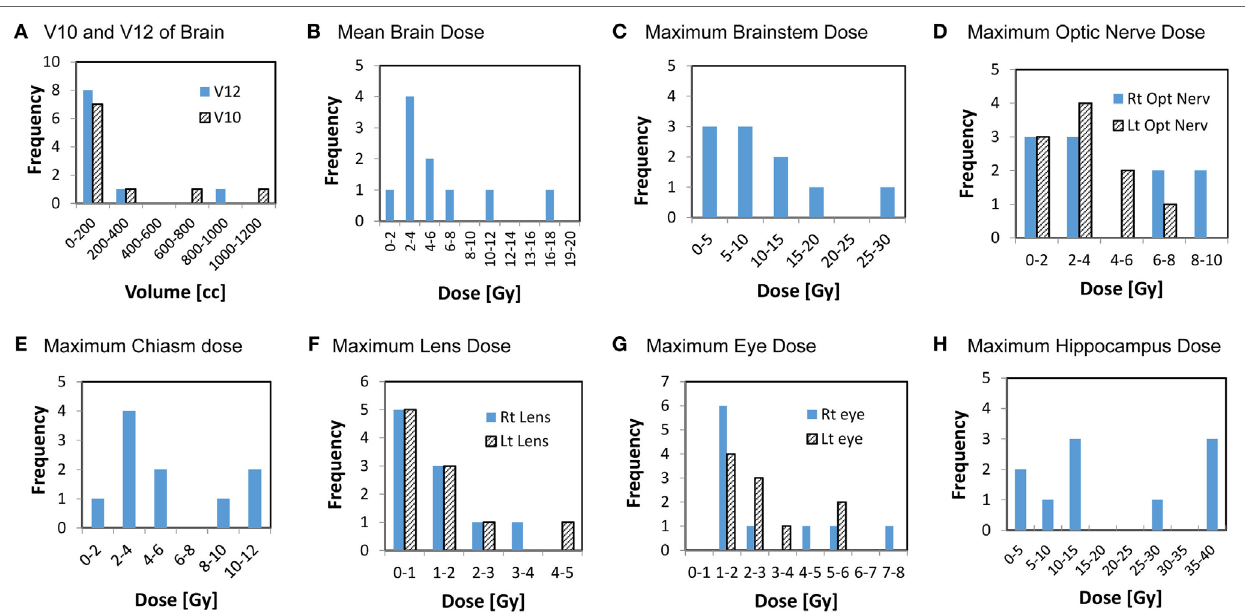
FigUre 4 | Histograms showing the distributions of the cumulative doses to critical structures from all GK sessions. Y axis represents the number of patients, x-axis represents dose or volume